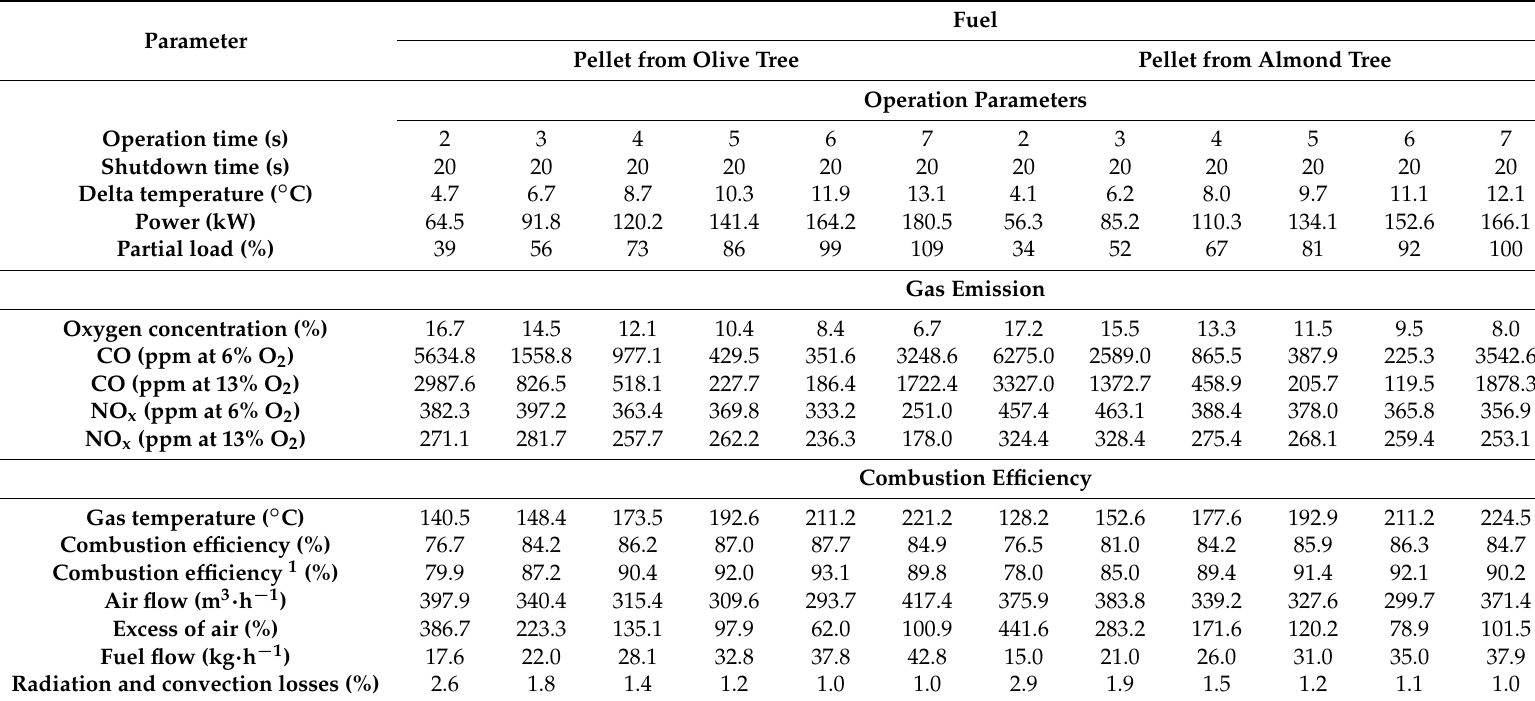
Table 4. Efficiency results obtained during combustion tests for pellets from olive and almond